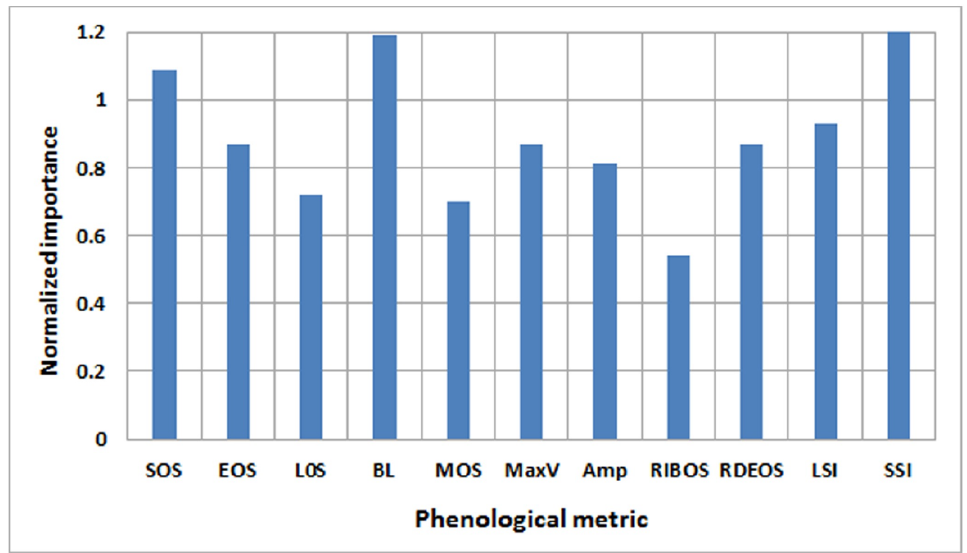
Figure 6. Importance of phenological metrics extracted from the EVI time series.